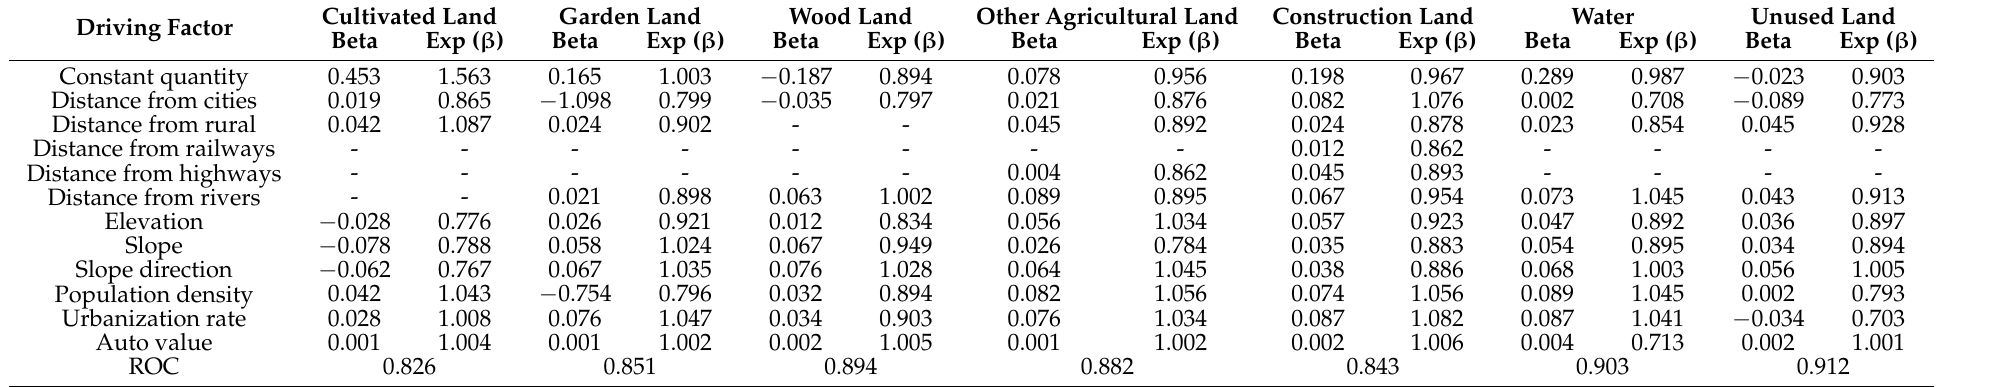
Table 3. The results of the auto logistic regression for different land use